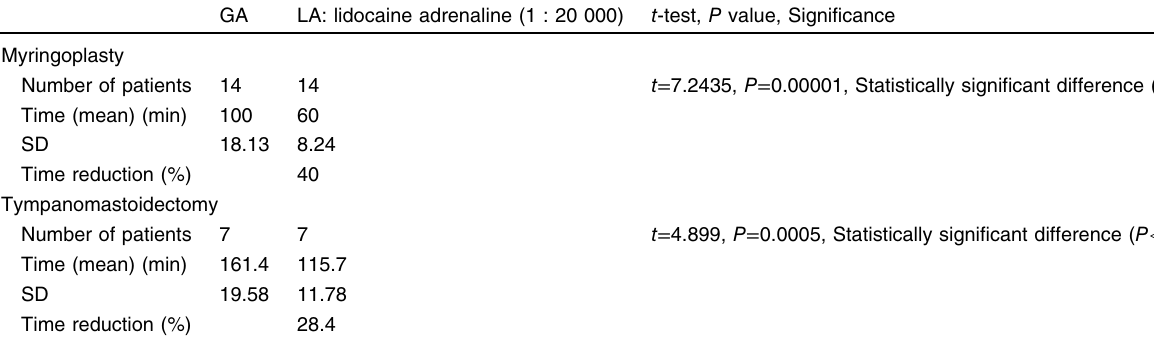
Table 2 Comparison of operative time under GA and LA in 21 cases for each group GA LA: lidocaine adrenaline (1 : 20